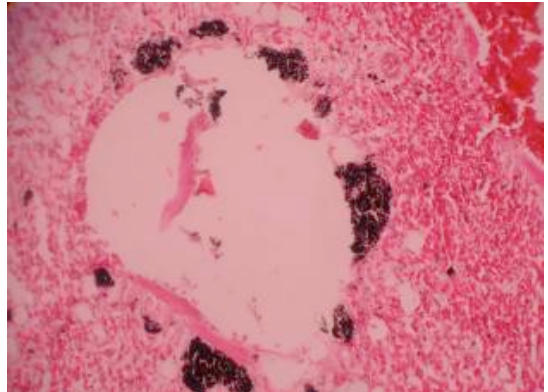
Image 17. Lung of Rhea showing deposition of carbon particles, congestion and collapsed alveoli, Anthracosis, H&E, 200x.